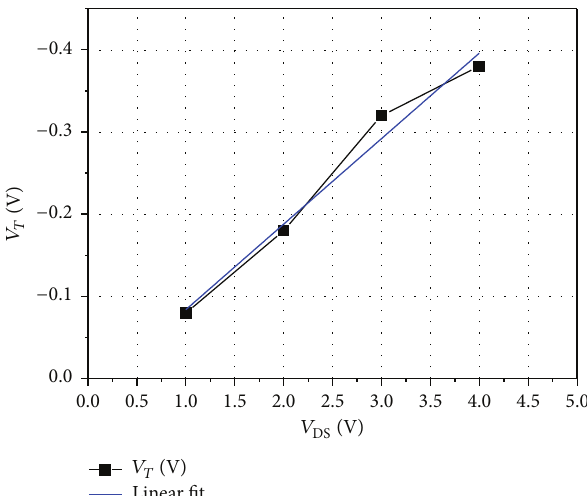
Figure 3: Linear variation of 𝑉 𝑇 extracted from Figure 2 as a function of 𝑉 DS showing the DIBL effect at 300 K.